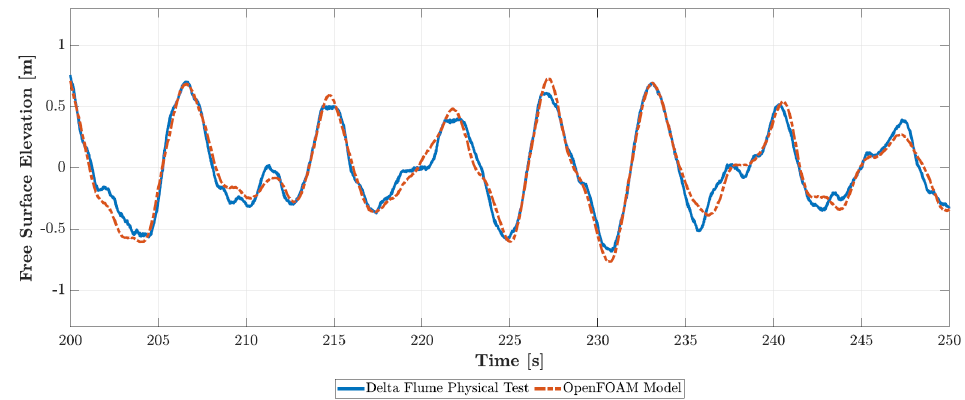
Figure 7. Free surface elevation of incoming waves at X = 108.5m from t = 200–250s in Test B.